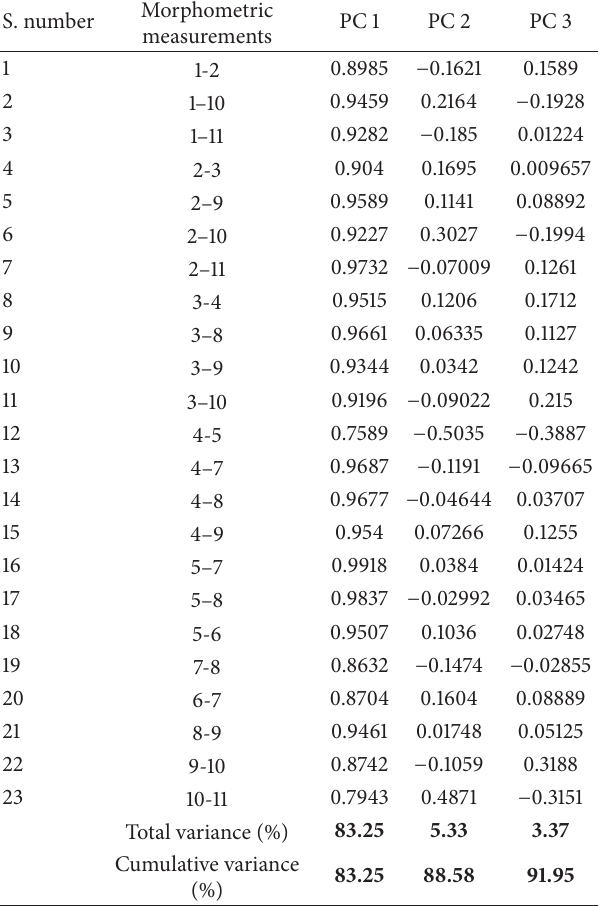
Table 2: First three principal components extracted from principal component analysis.